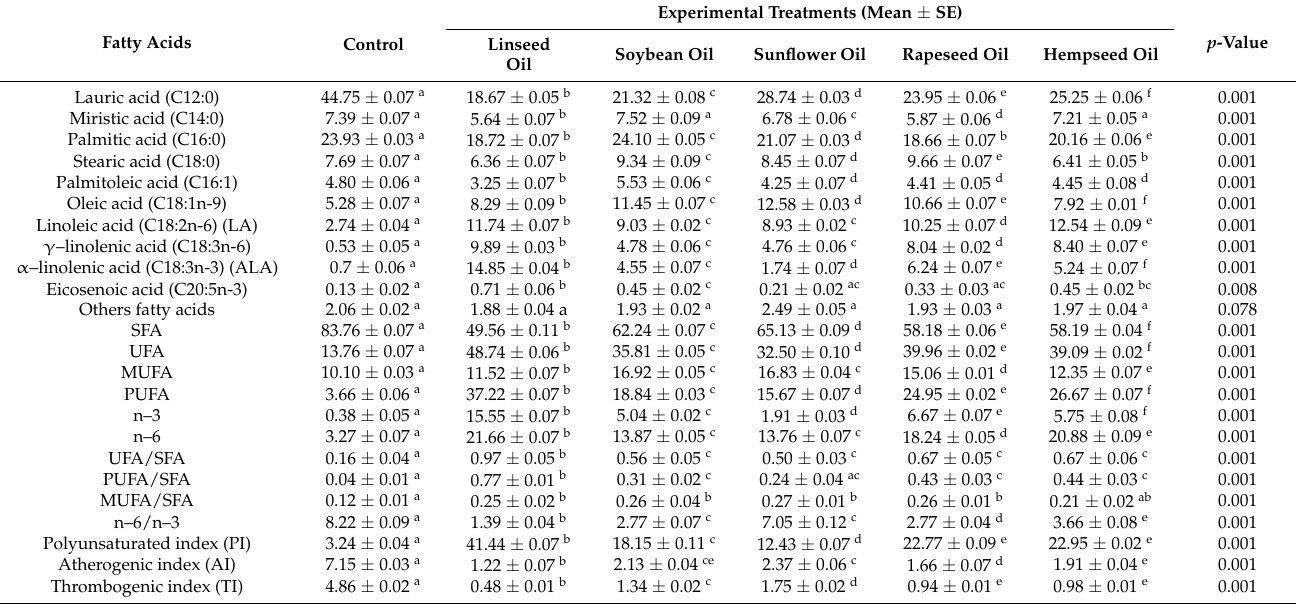
Table 3. The influence of vegetable oil inclusion in the diets of 10-day-old larvae on the fatty acid profile of fats (% of FAME).